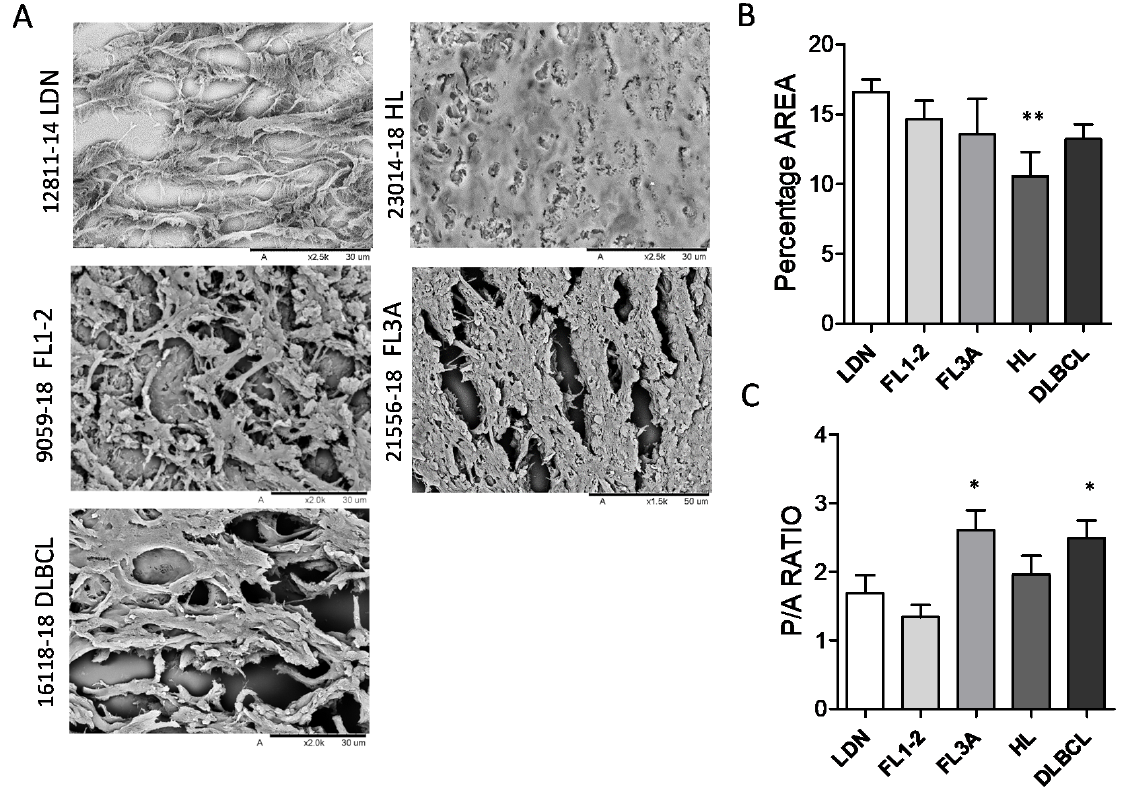
Figure 2. Ultrastructure of lymph node ECM in HL and NHL. ECM samples from HL ( n = 6), FL1-2 ( n = 6), FL3A ( n = 6), DLBCL ( n = 6) and LDN ( n = 6) were paraffin embedded, serially cut as 10 µm thick sections and analyzed by SEM (Hitachi TM 3000). Panel ( A ): Sample slices of representative LDN, HL, FL1-2, FL3A and DLBCL Bar in each image: 30 µm. Panel ( B , C ): Areas of matrix or empty spaces were calculated with a tool of the ImageJ software and reported as percentage area on the whole image analyzed ( B ) or as perimeter/area (P/A) ratio of empty spaces ( C ). Mean ± SEM from 6 images analyzed for each histological type. Panel B: ** p < 0.005 vs. LDN, 0.05 vs. FL1-2 and FL3A. Panel ( C ): * p < 0.05 vs. LDN, FL1-2 and HL. These data indicate that several modifications of the ECM apply to lymphomas. Physi-